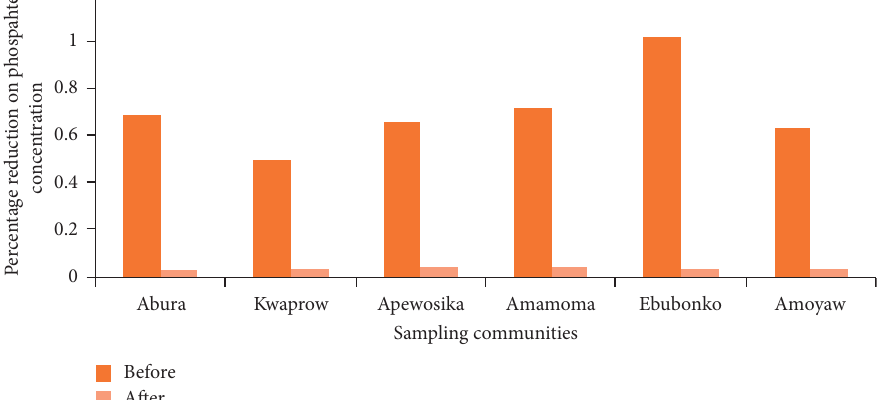
Figure 6: A graph of percentage reduction in phosphate concentration after two hours of treatment with ZSM-11.